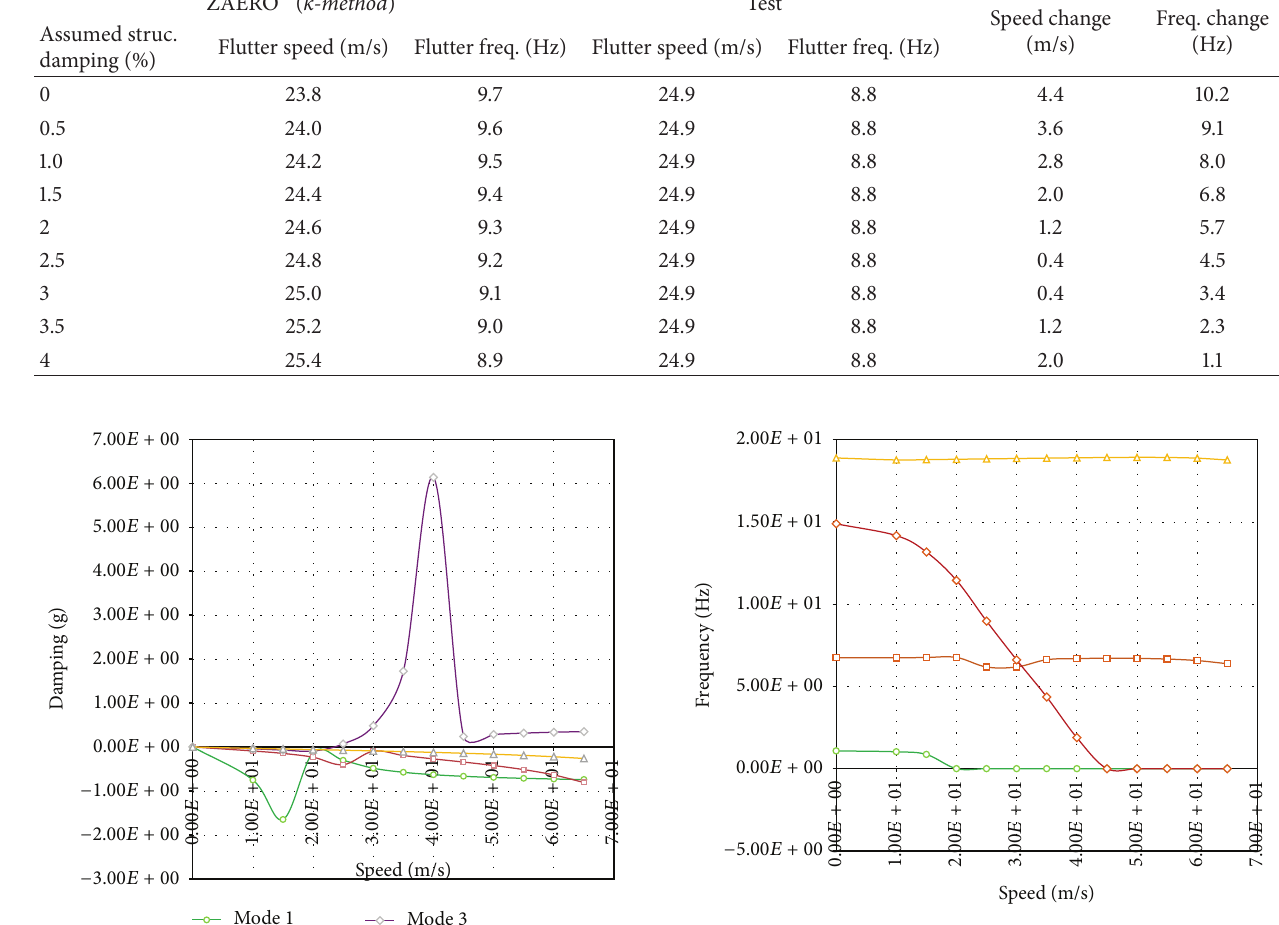
Speed change Freq. change (m/s)